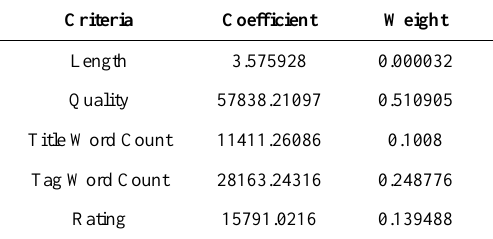
Figure 4. Log Distribution of Primary Independent Variables Table 1. Identified Criteria with Calculated